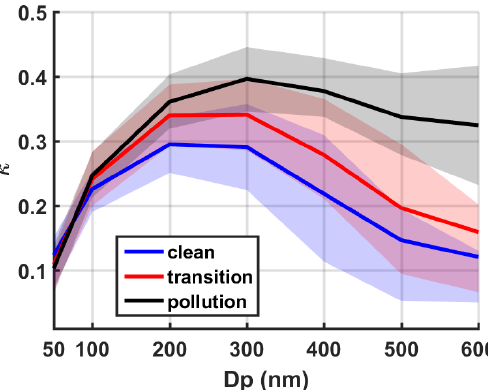
Figure 6. Mean size-resolved κ under different pollution condi- tions. The upper and lower limit of semi-transparent patch is the 25% and 75%